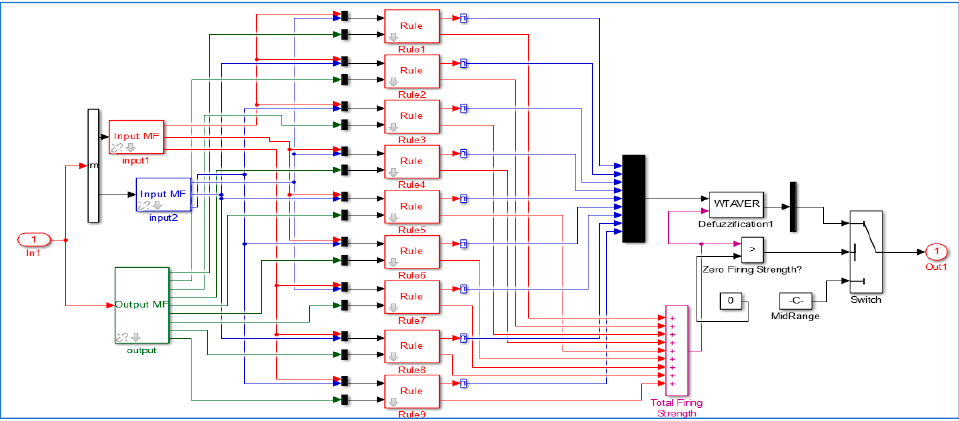
Figure 8. ANFIS structure in Matlab-Simulink GUI.